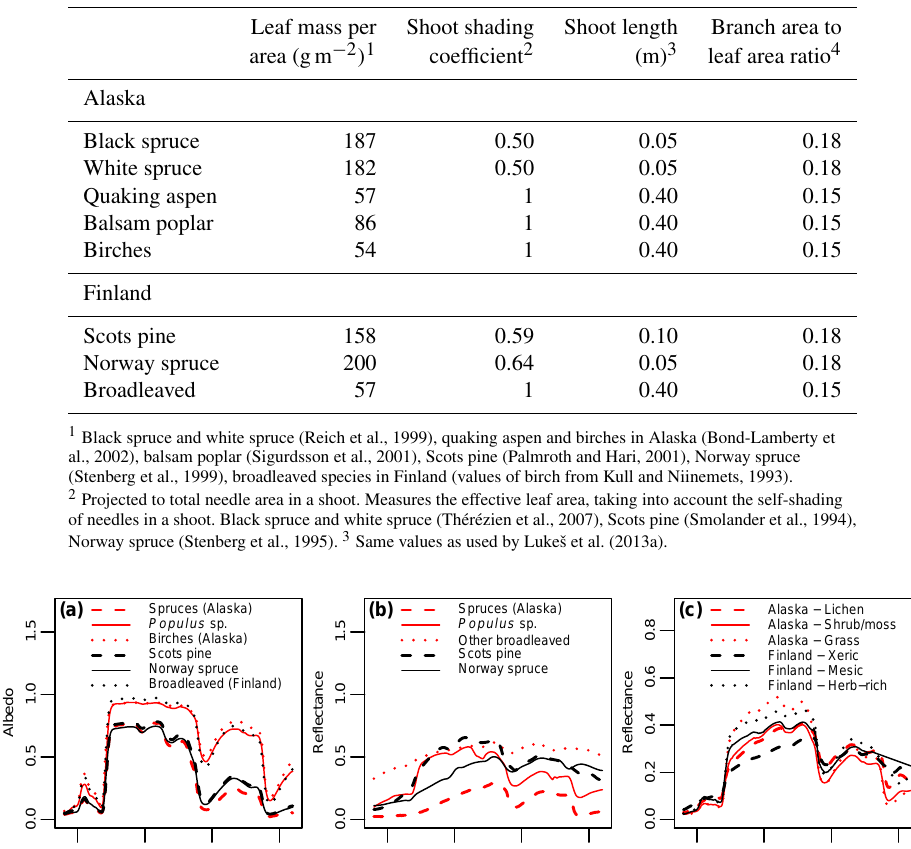
Table 3. Structural input parameters used in the FRT model simulations.